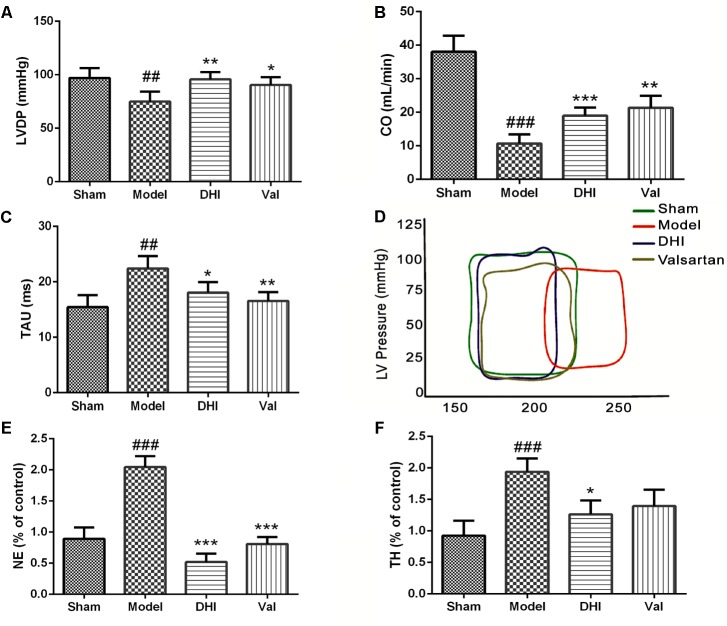
Danhong injection regulated the hemodynamic and neurotransmitter. Quantitative assessment of hemodynamics on cardiac function based on (A) left ventricular developed pressure (LVDP) = left ventricle-end systolic pressure minus left ventricle end diastolic pressure, (B) cardiac output (CO) and (C) relaxation time constant, were all significantly dysregulated in the MI rat model (##p < 0.01 and ###p < 0.001 vs. sham), but was regulated by treatment with DHI and valsartan (∗p < 0.05, ∗∗p < 0.01, and ∗∗∗p < 0.001 vs. model). (D) Left ventricular PV-loop. Valsartan and DHI-treatment enhanced improved ventricle and in the same way with the sham group contrarily to the model. (E,F) Bar graph representation of ELISA quantification for NE and TH in rat serum. The levels of NE and TH were increased in the model group compared to the sham (###p < 0.001 vs. sham). DHI significantly ameliorated the levels of NE and TH (∗p < 0.05 and ∗∗∗p < 0.001 vs. model), respectively (n = 6 in each group, data are presented as mean ± SEM).